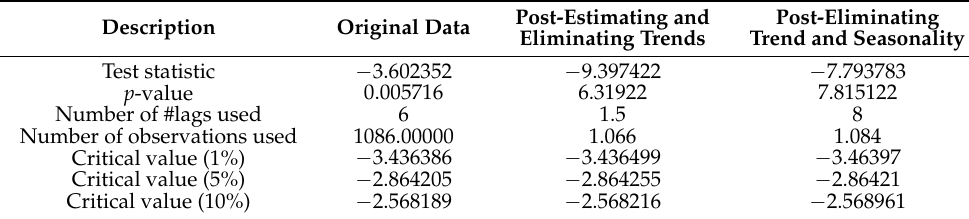
Table 2. Initial Dickey–Fuller test of the original